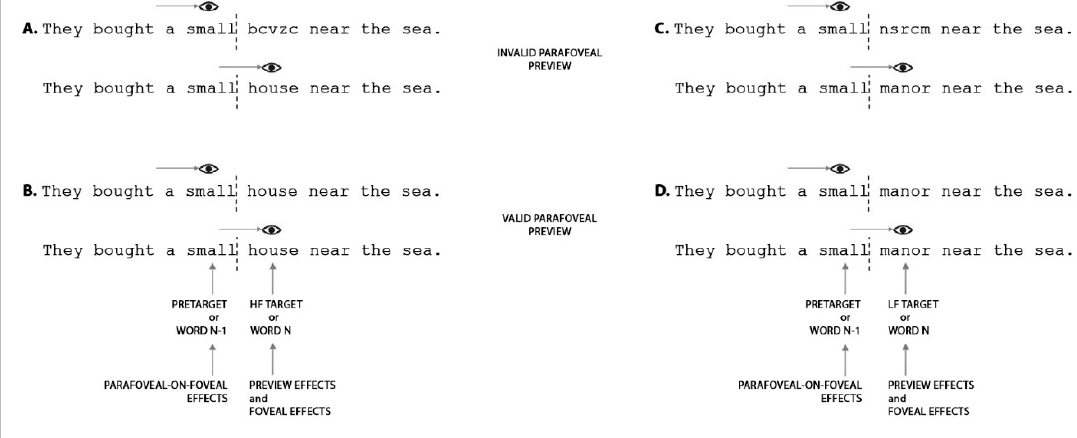
parafoveal previews (i.e., ‘bcvzc’, ‘house’, ‘nsrcm’, ‘manor’) have on the processing of the target word